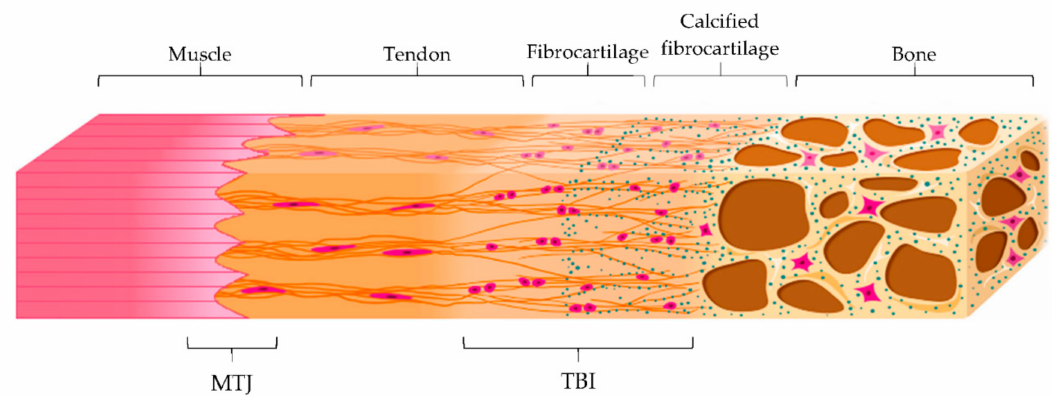
Figure 3. Schematic representation of the myotendinous junction (MTJ) and the tendon-to-bone interface (TBI) with its different zones: tendon, fibrocartilage, calcified fibrocartilage and bone. Modified from [30]. CC BY